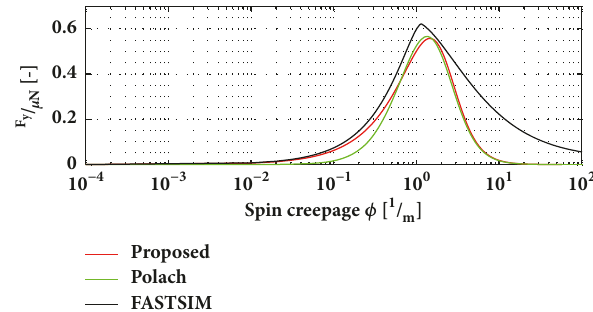
Figure 10: Lateral force versus spin creepage in presence of a constant longitudinal creepage ( 𝜉 = 0.003).